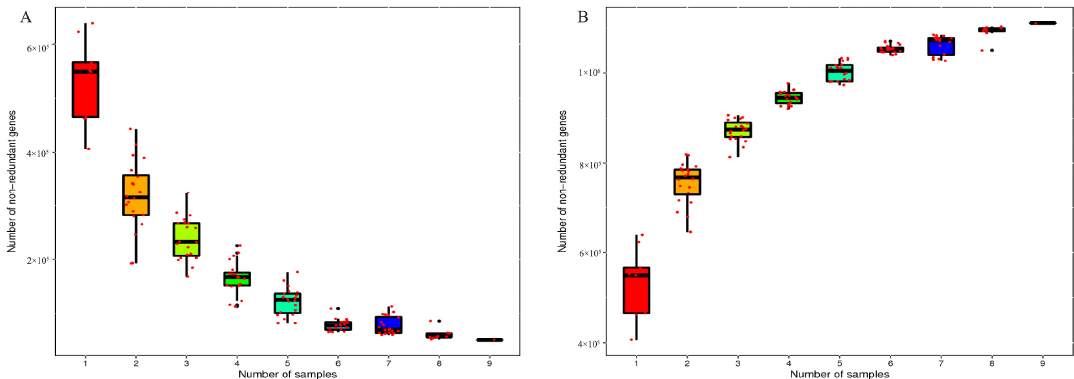
Figure 1. Dilution curve of core-pan gene. The figure ( A ) is the core gene dilution curve; the figure ( B ) is the pan gene dilution curve. The X-axis represents the number of samples taken; the Y-axis represents the number of genes in a sample